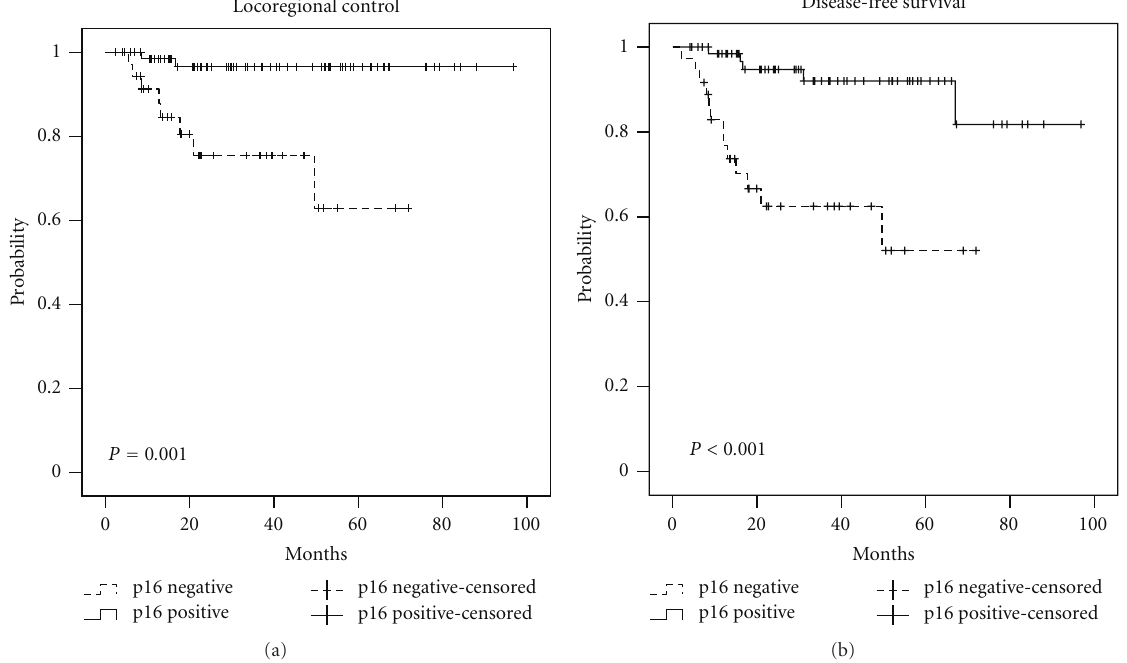
Figure 1: Locoregional control and disease-free survival stratified by p16 status.